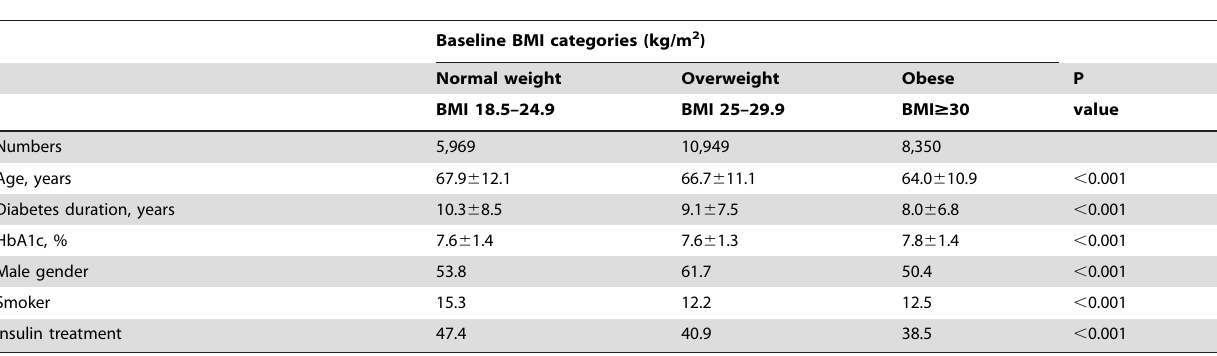
Table 1. Baseline characteristics in all patients with type 2 diabetes, and by different categories defined according to baseline